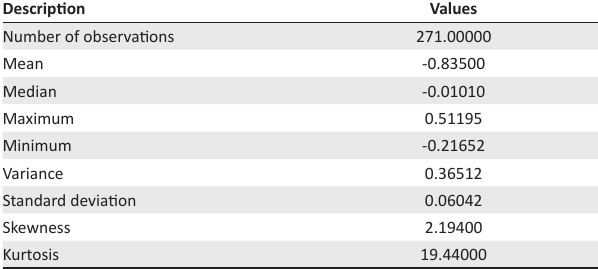
TABLE 1: Monthly log returns of the J580 Index descriptive